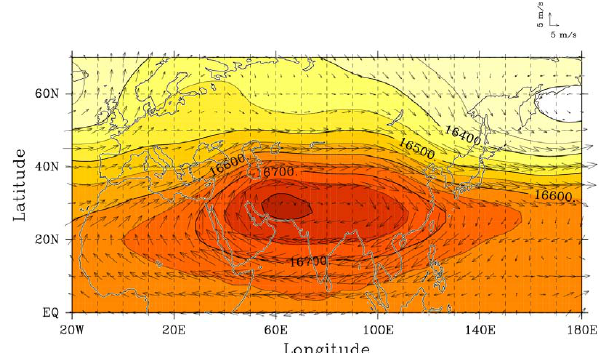
Fig. 4. Monthly means of geopotential height (m) and wind (m s − 1 ) on 100hPa in June 2011 calculated from NCEP/NCAR reanalysis data. The wind speed scale is shown above the right side of the